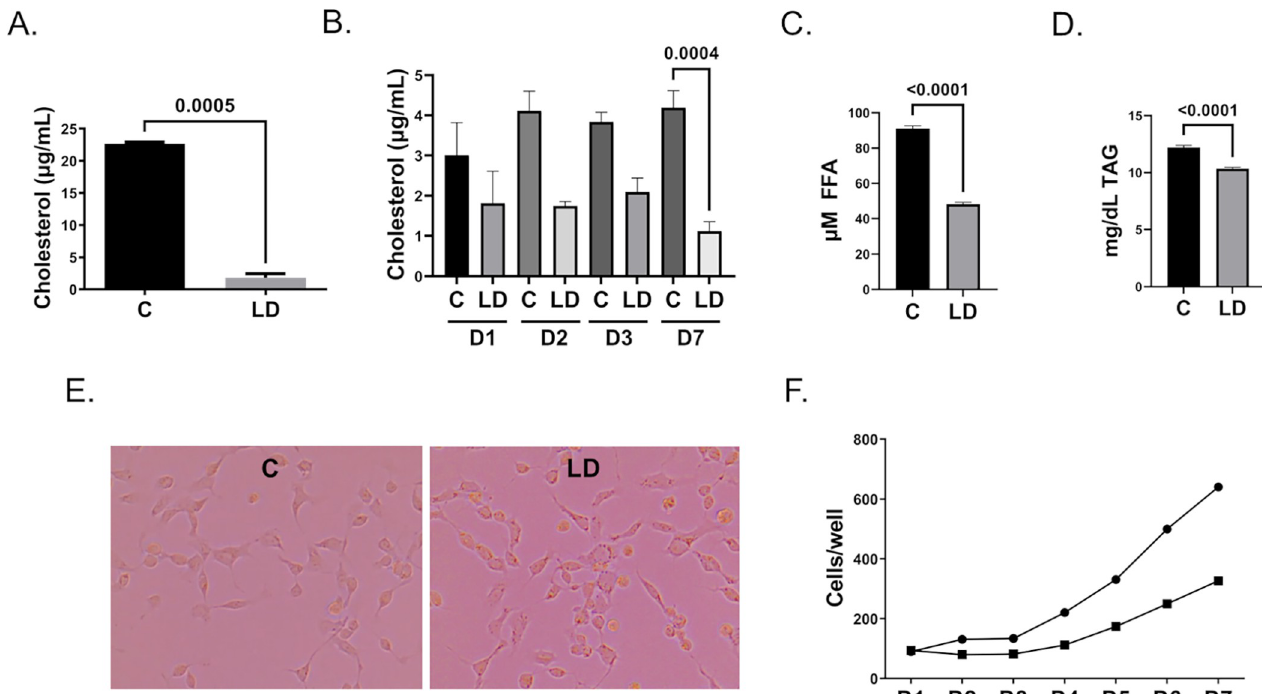
Fig 1. Lipid-depleted cell culture media has less cholesterol, free fatty acids, and triacylglycerol, but can support replication of LD-Aag2 cells. (A) Amplex Red cholesterol assay of complete (C) and lipid-depleted (LD) cell culture media. ( B) Amplex Red cholesterol assay of C-Aag2 and LD-Aag2 cell lysates at days 1, 2, 3, and 7 post-treatment with C and LD cell culture media. (C) Free fatty acid (FFA) assay of complete C and LD cell culture media. (D) Triacylglycerol assay of C and LD cell culture media. ( E) Representative images of C-Aag2 and LD-Aag2 cells. (F) Cell proliferation assay of C-Aag2 (circles) and LD-Aag2 (squares) over a 7-day period. Assays were performed in triplicate. Unpaired Student’s t tests were performed between groups to assess statistical significance. Standard deviations are shown.